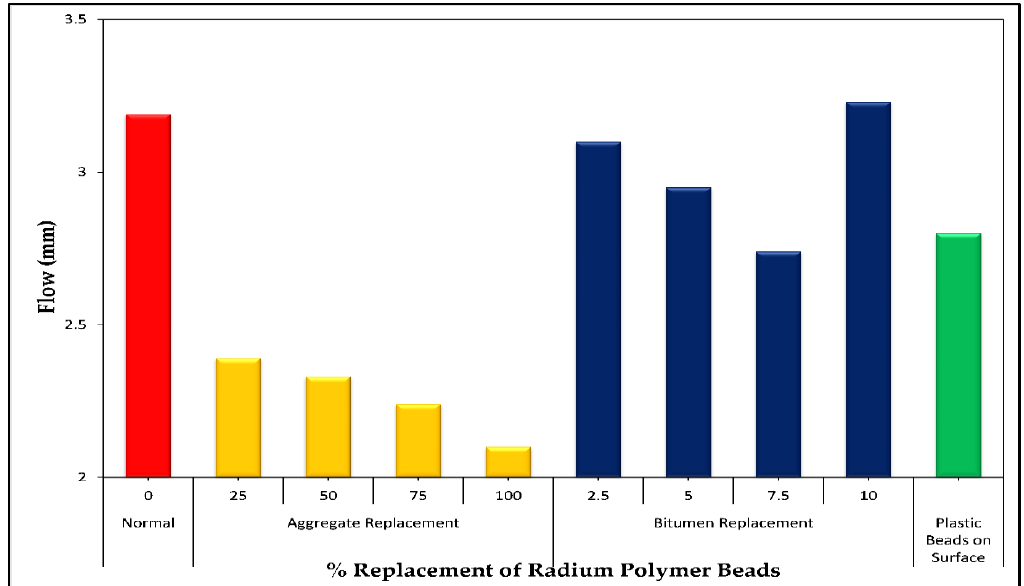
Figure 12. Marshall flow versus radium polymer materials.